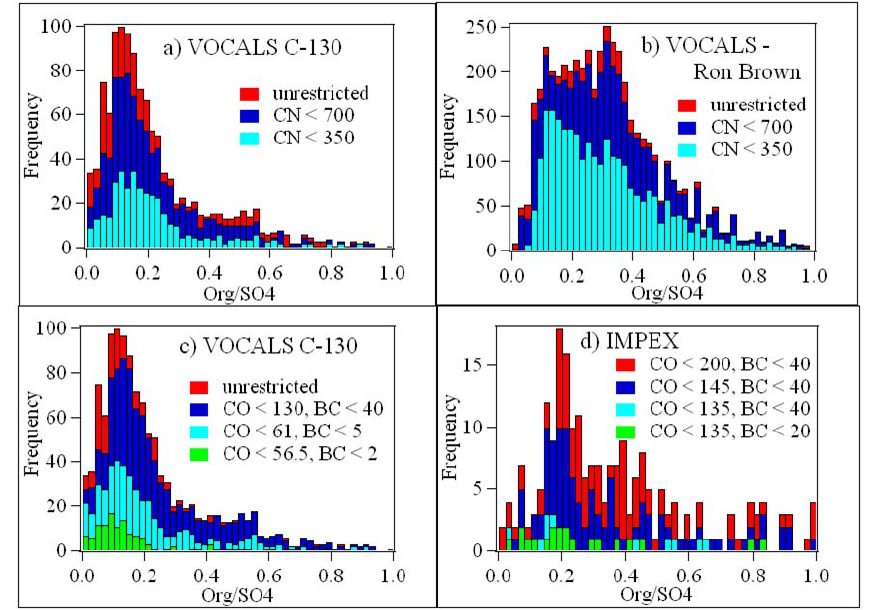
Fig. 8. Histograms of Org/SO 4 from different platforms and campaigns, restricted to varying clean air criteria. Units are as follows: CN (cm − 3 ) , CO (ppb), and BC (ngm − 3 )